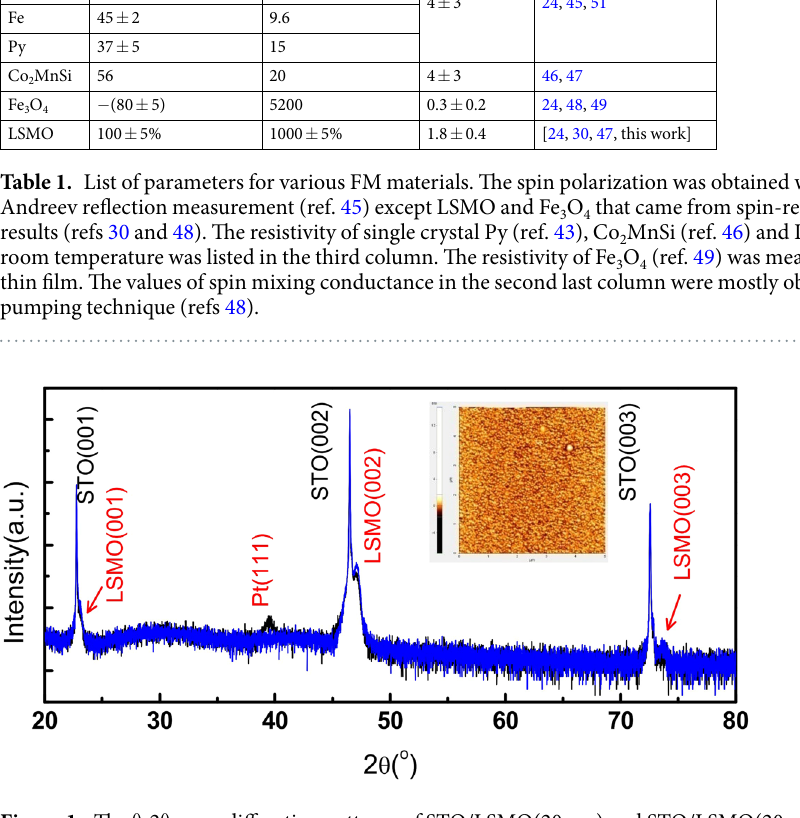
Figure 1. The θ -2 θ x-ray diffraction patterns of STO/LSMO(20 nm) and STO/LSMO(20 nm)/Pt(30 nm), represented by the blue and the black curves respectively. The inset shows the AFM image (scanning area 5 × 5 μ m 2 ) taken on the surface of STO/LSMO(20